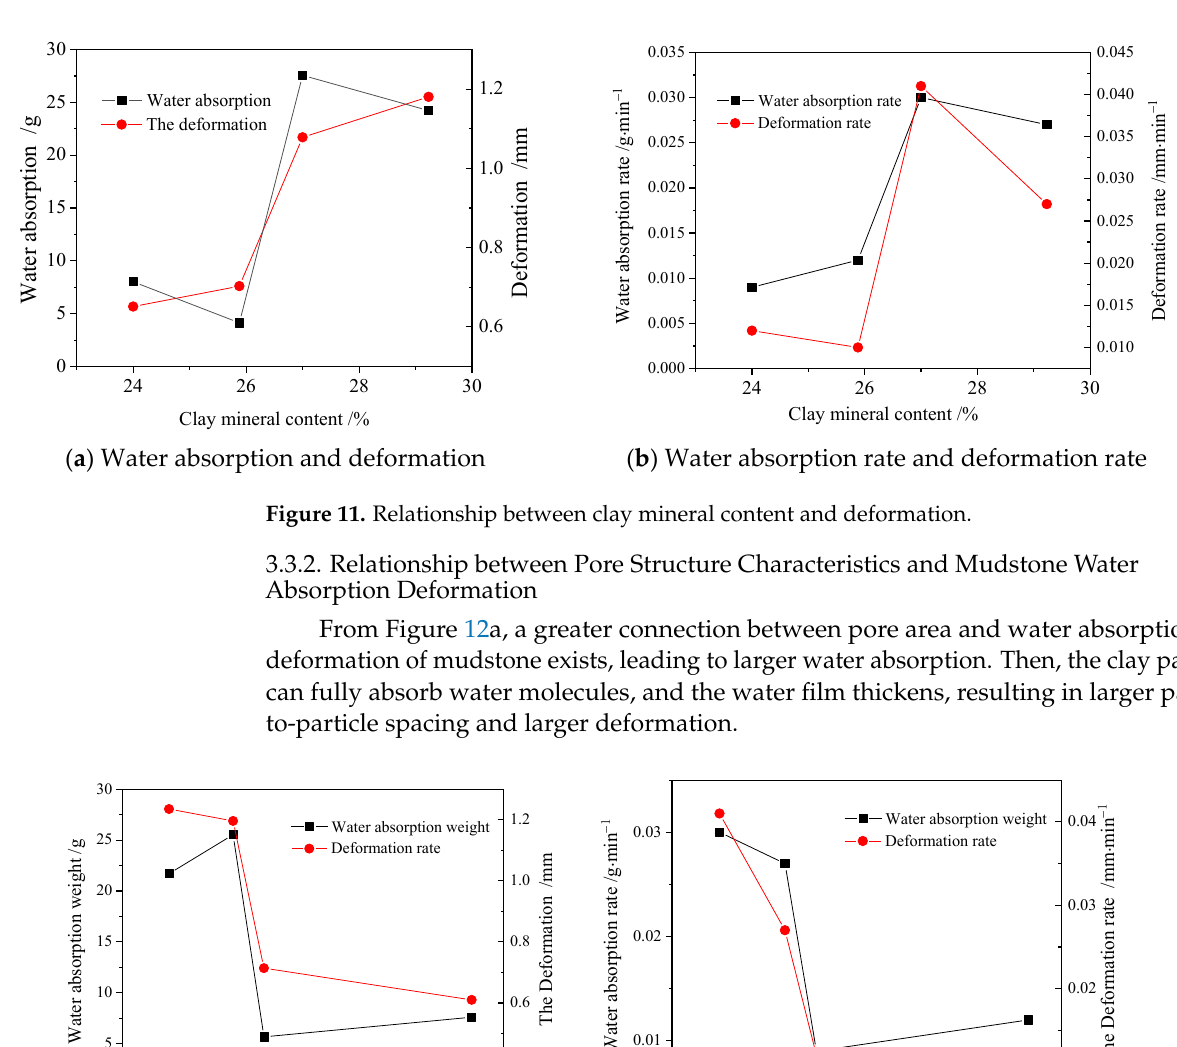
Figure 13. Diagram of particle–boundary interaction. The mudstone swelling by water absorption is given by the following equation de- veloped by Equation (1) [33,34]: 1